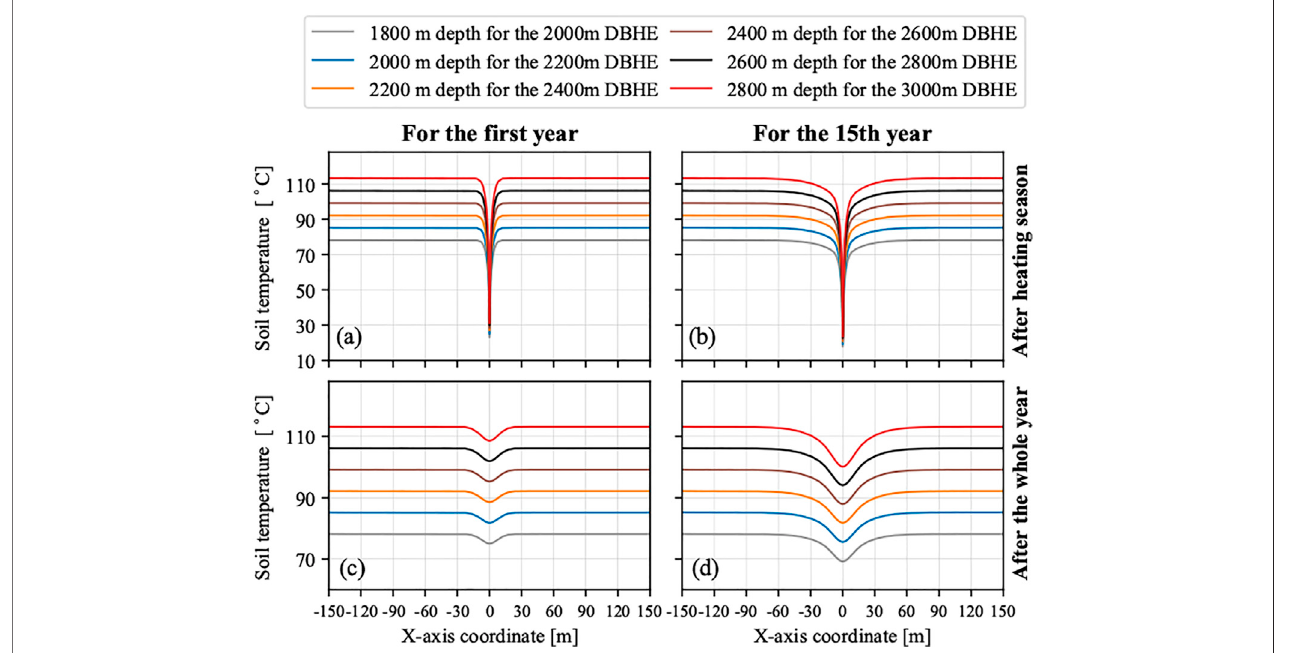
FIGURE5| SoiltemperaturedistributionfortheDBHEwithdifferentdrillingdepths (A) attheendofthe fi rstheatingseason; (B) attheendofthelastheatingseason; (C) at the end of fi rst year; (D) at the end of last year.